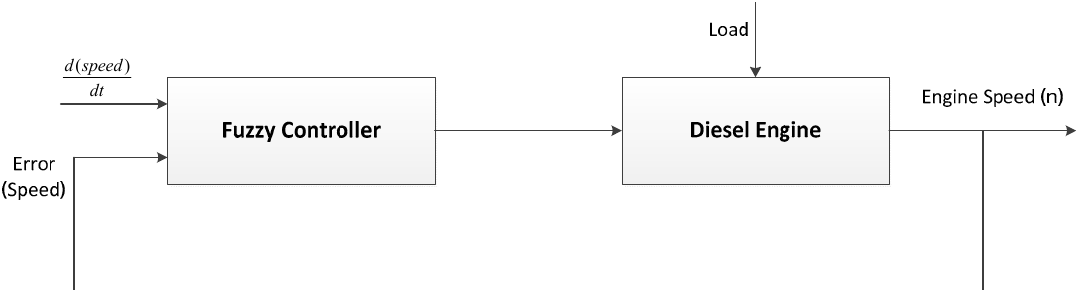
Figure 5. Modelling of diesel engine speed control by fuzzy logic controller.